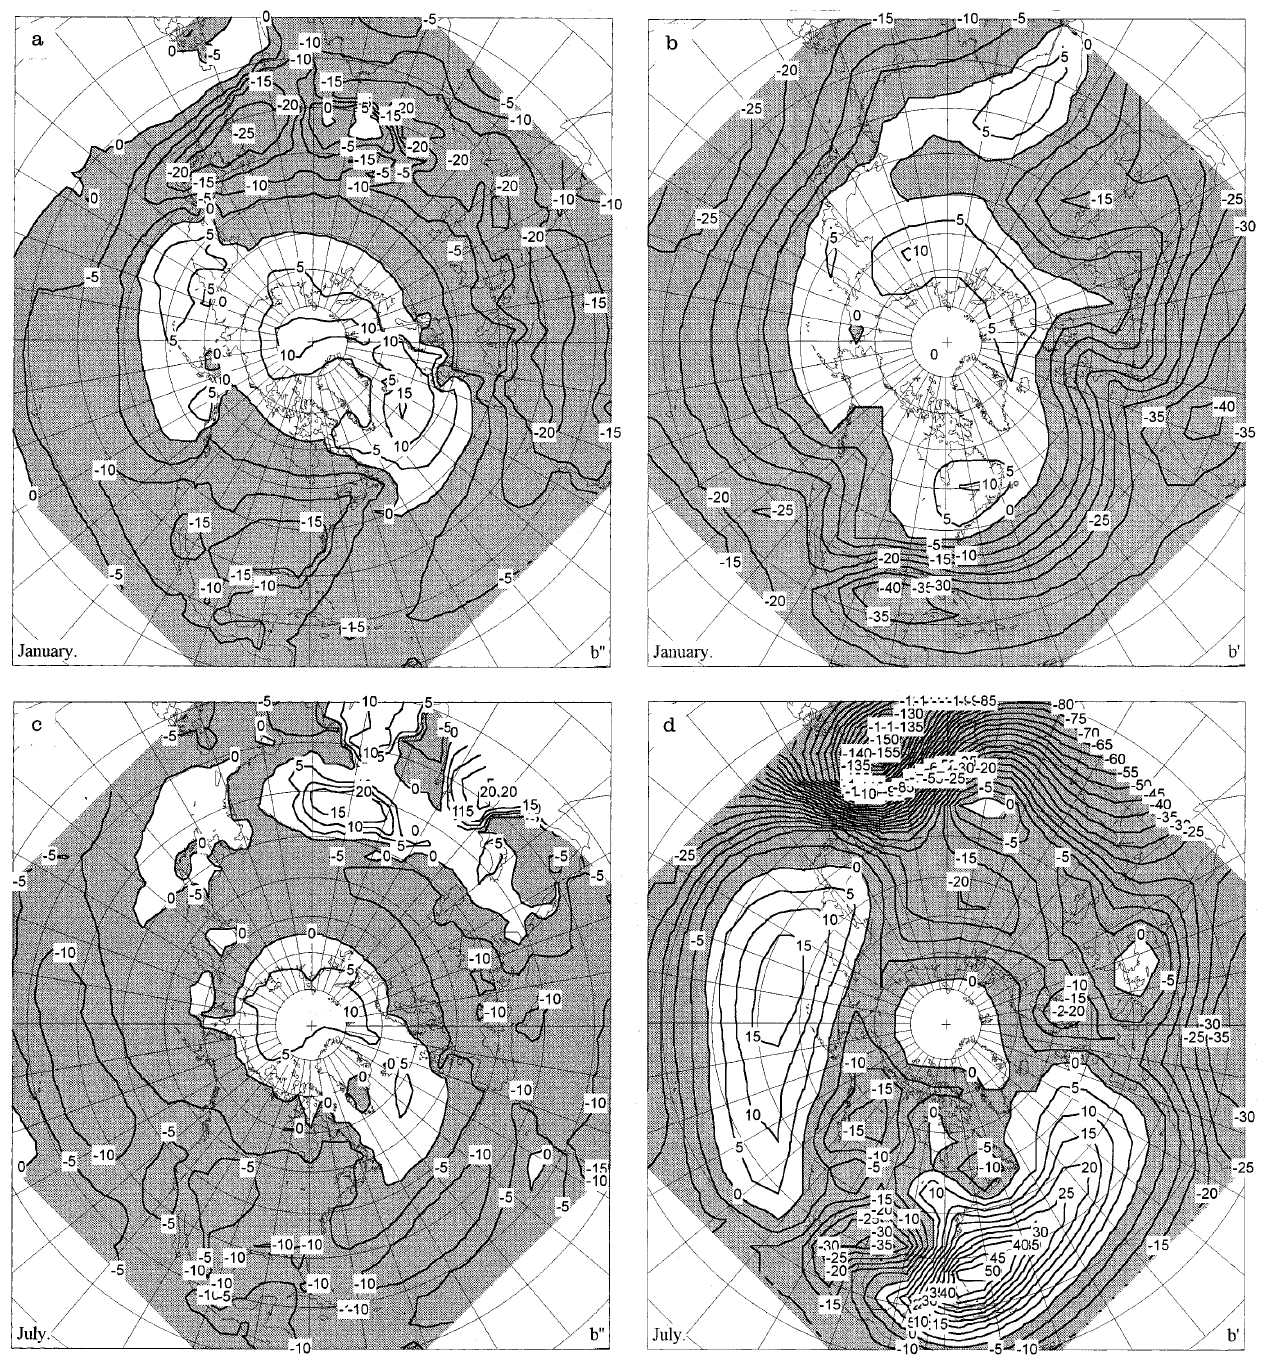
Fig. 2a–d. Geographical patterns of the b 00 coe(cid:129)cient in the theoretical Eq. (46), and the b 0 coe(cid:129)cient in the Clapp et al. (1965) formula, computed in 2 Wm (cid:255) 2 K (cid:255) 1 . a is the b 00 coe(cid:129)cient for winter, b the b 0 coe(cid:129)cient for winter, c the b 00 coe(cid:129)cient for summer, and d the b 0 coe(cid:129)cient